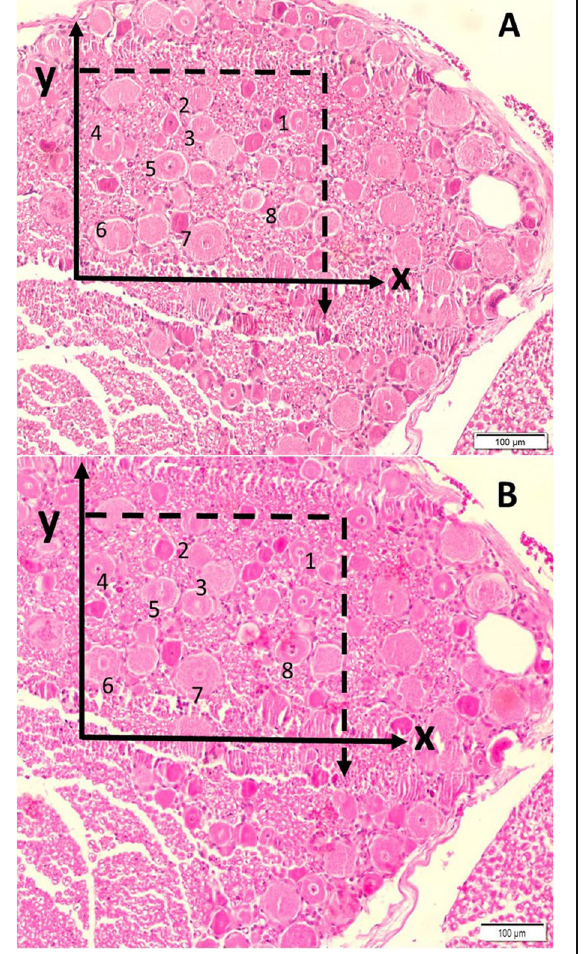
penile neurovascular structures of a circumcised rabbit under anaesthesia just before scarification. Figure 5 dis- plays the anatomical representation of the sacral spinal cord (SC), pudendal NR and dorsal root ganglions; spinal cord section at Onuf ’ s nucleus level and the histo- pathological appearance of the spinal cord, the artery of